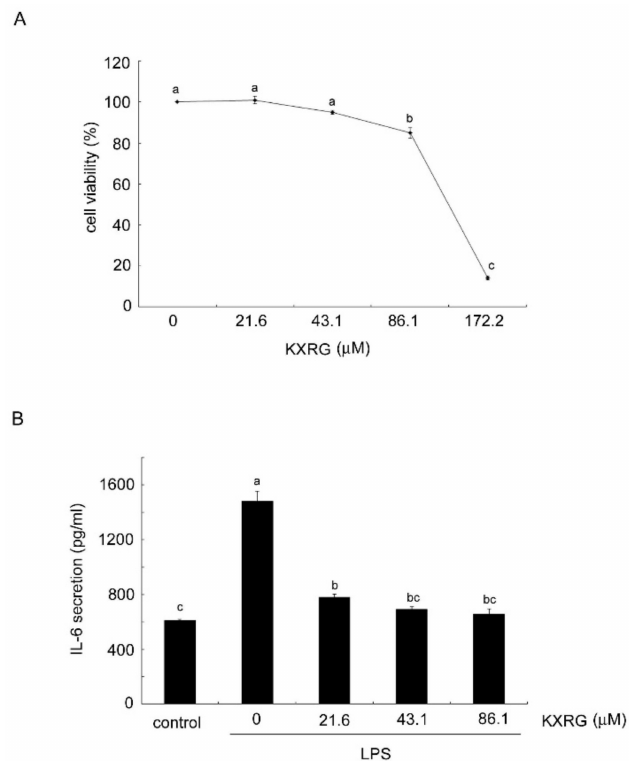
Figure 2. Anti-inflammatory activity of KXRG in cultured RAW264.7 cells. ( A ) Cytotoxicity of KXRG towards RAW264.7 cells, ( B ) effect of KXRG on the inhibition of IL-6 secretion in LPS-stimulated RAW264.7 cells. Cells were pre-treated with non-toxic concentrations of KXRG for 2 h, followed by incubation with 1 µ g/mL LPS. IL-6 levels in the culture media were measured. Bars marked with different letters indicate statistically significant differences among groups at p <